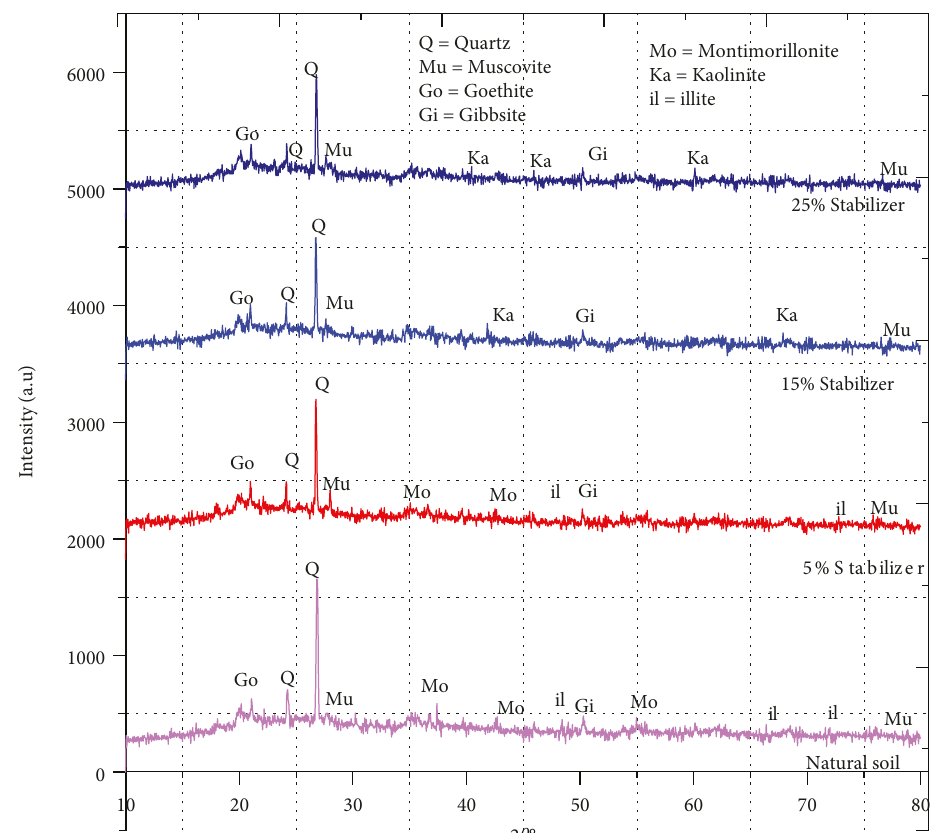
Figure 10: Stacked XRD graph with chemical